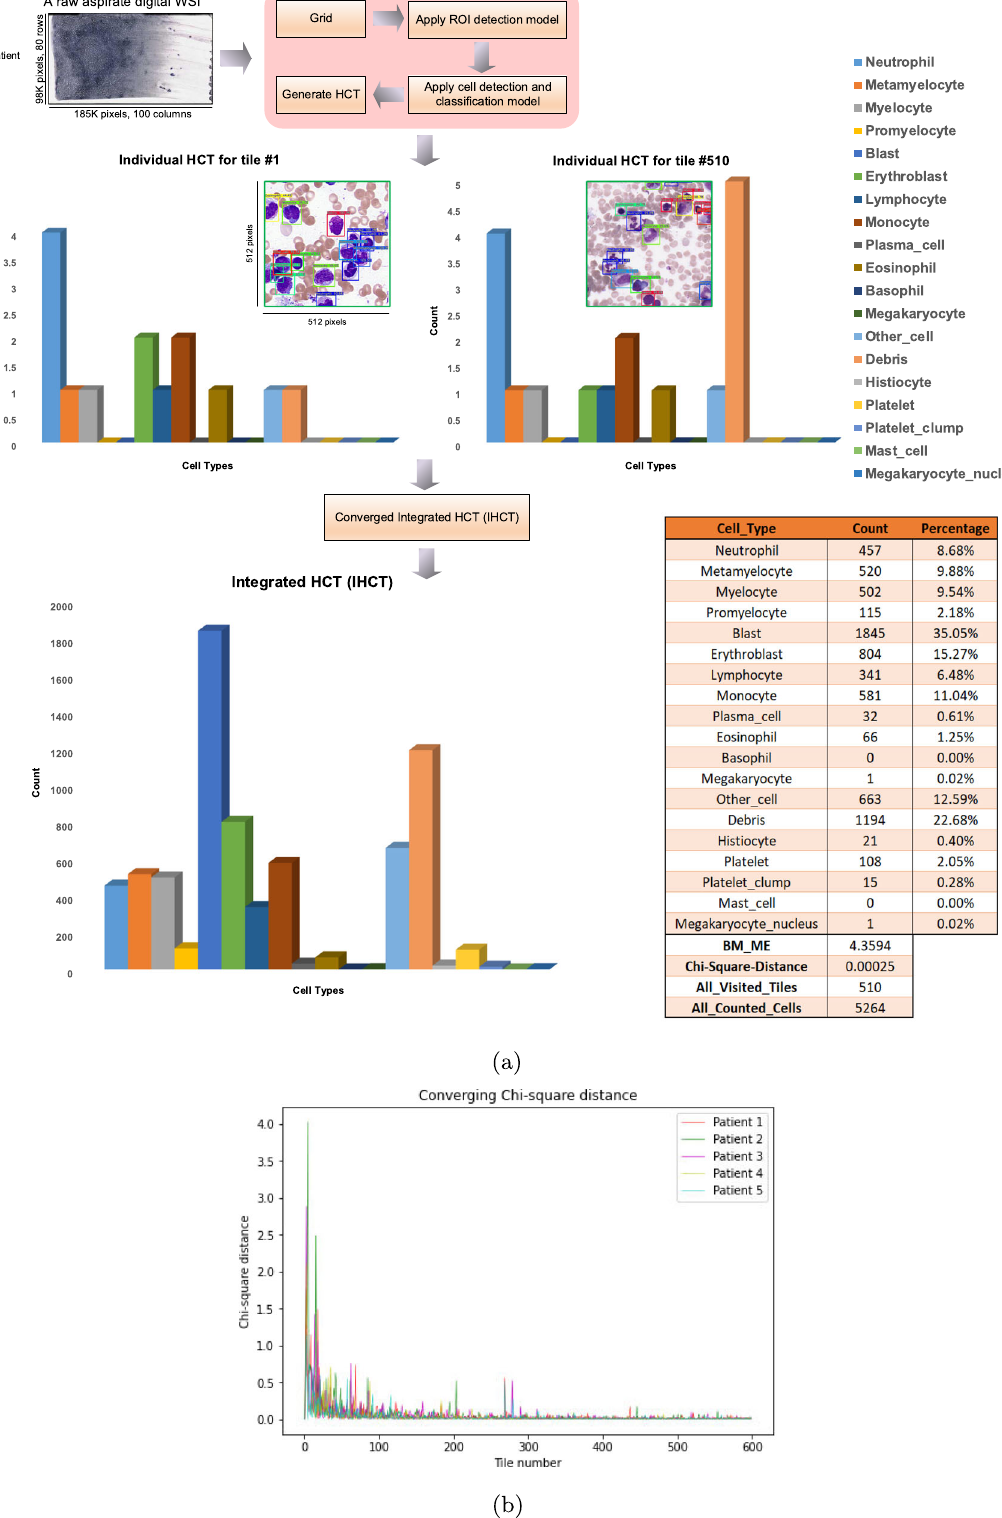
Fig. 5 Generating the Histogram of Cell Types (HCT) and converged Integrated Histogram of Cell Types. a Each histogram of cell types (HCT) is created individually for each Region of Interest (ROI) tile. The Integrated HCT (IHCT) is then updated as successive ROI histogram are accumulated. This process is stopped once the IHCT is converged using the Chi-square ( χ 2 ) distance. Collective cytological information from a patient bone marrow aspirate is then represented as an IHCT and a table with summary statistics such as the number of each cell type, percentage, BM ME ratio and Chi-Square distance. b Variation of the Chi-square distance through visiting and analyzing selected ROI tiles by the architecture and how an IHCT is converged by processing each tile. For fi ve samples of patients, the IHCT is converged after visiting a number of tiles in the range of 400 to 500